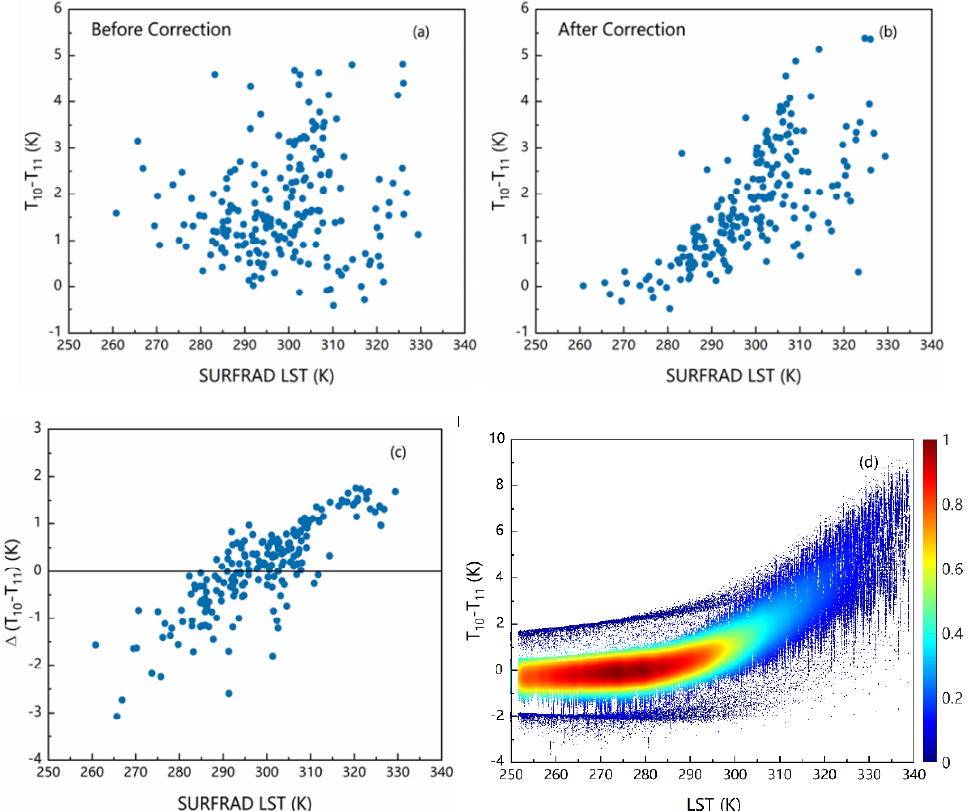
Figure 3. Relationship of brightness temperature difference ( T 10 − T 11 ) and ground-measured LST (denoted as SURFRAD LST). ( a ) Before the stray light correction and ( b ) after the stray light correction. ( c ) Change (Δ( T 10 − T 11 )) in the brightness temperature difference before and after the stray light correction. ( d ) Density scatter plot of ( T 10 − T 11 ) and LST in the simulation dataset.